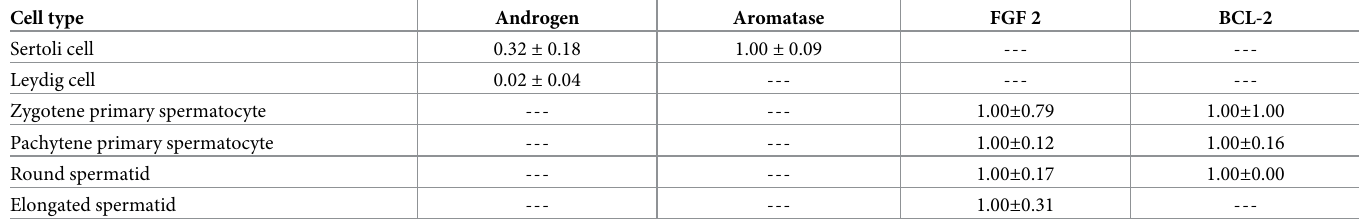
Table 5. Expression frequency of the androgen receptor, aromatase, FGF 2 and BCL-2 of Diphylla ecaudata testes. The data are reported as mean ± standard devia- tion (SD) of the